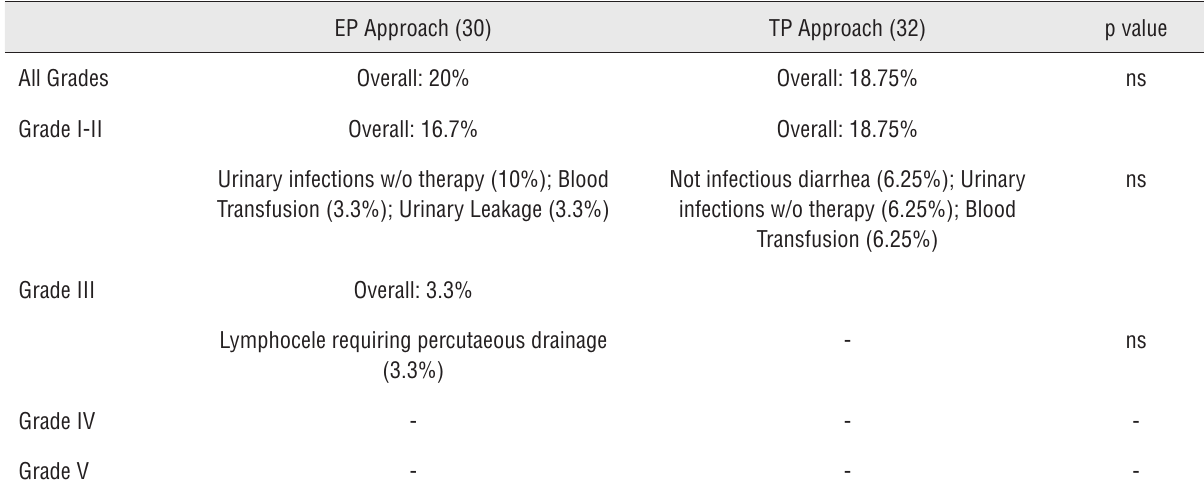
Table 2 - Post operative complications according to Clavien-Dindo